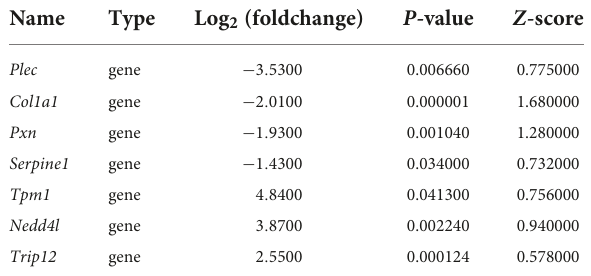
TABLE 3 Summary of key genes.